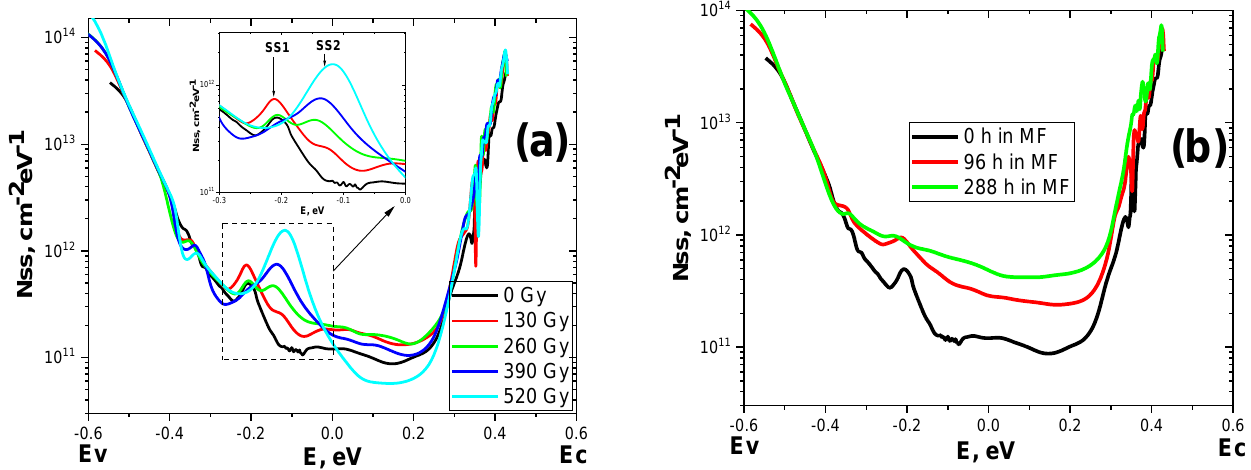
Figure 4. Radiative ( a ) and magnetically ( b ) stimulated changes in the charge states of the Si–SiO 2 interface in the Bi-Si-Al surface barrier structures (distribution of the density of fast surface states in the silicon band gap).